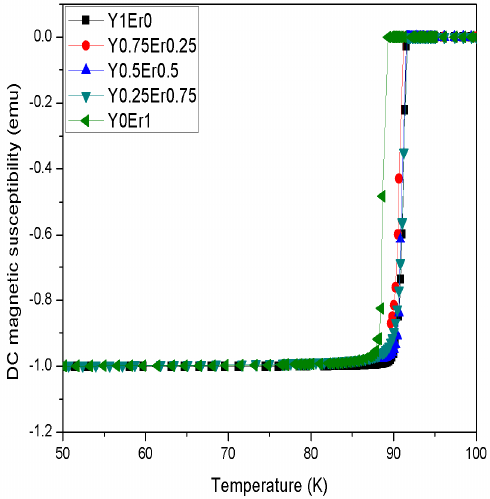
Figure 7. Temperature dependence of normalized magnetization.